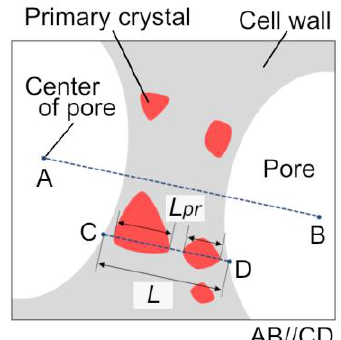
Figure 4. Definitions of each measurement parameter. L is the width of the cell wall. L pr is the length of the primary crystals.